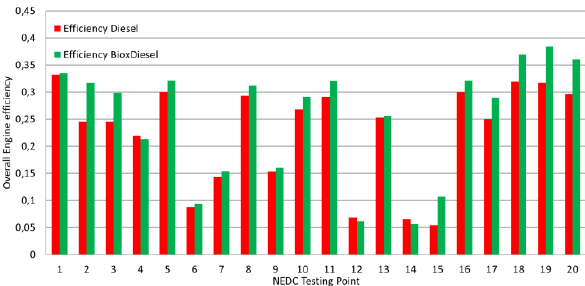
Fig. 6. Comparison of the overall engine efficiency for the engine fed with Bioxdiesel and Diesel fuel for selected operation points according to NEDC